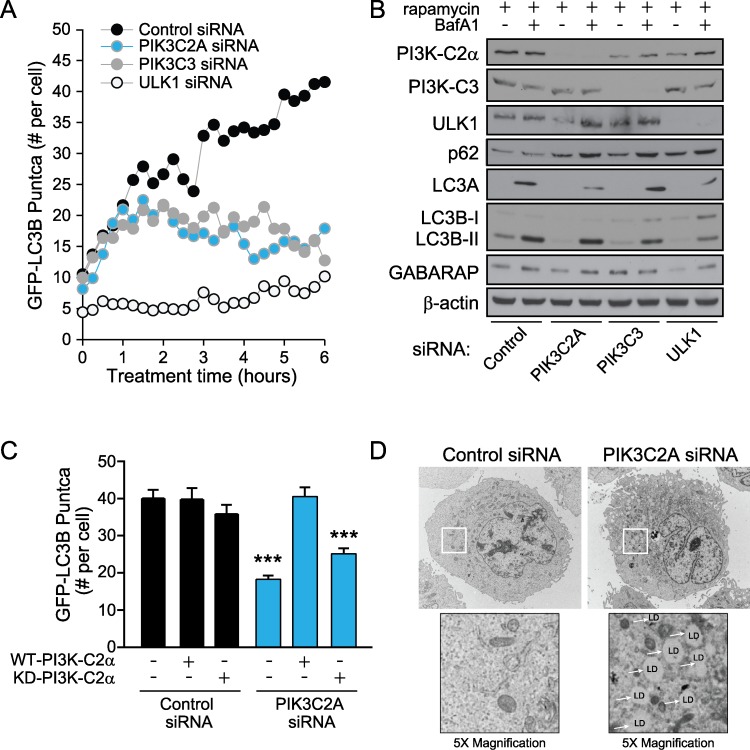
PI3K-C2α knockdown inhibits sustained autophagy and results in the formation of lipid droplets.(A) U2OS cells stably expressing ptfLC3B were transfected with siRNAs directed to PIK3C2A, PIK3C3, and ULK1 for 48 hours. Live-cell imaging was carried out for six continuous hours after addition of rapamycin (50 nM) to measure changes in GFP-LC3 puncta accumulation. (B) U2OS cells were transfected with siRNAs directed to PIK3C2A, PIK3C3, and ULK1 for 48 hours, and then treated with rapamycin (6 hours) to induce autophagy in the absence or presence of BafA1 (90 mins). ATG8 isoforms (LC3A, LC3B, and GABARAP) and p62 (SQSTM1) were examined to detect changes in autophagy. (C) U2OS cells stably expressing EGFP-LC3B were transfected with siRNAs directed to PIK3C2A for 48 hours. After 24 hours, siRNA-resistant wild-type protein (WT-PI3K-C2α) or siRNA-resistant kinase-dead protein (KD-PI3K-C2α) was transfected. After an additional 24 hours, cells were treated with rapamycin for 6 hours and number of puncta per cell counted from exogenous PI3K-C2α expressing cells. Representative images are shown in S3 Fig. Data represent means of n ≥ 25 cells with standard error of the mean. Unpaired t test, comparing experimental to control. ***denotes p < 0.001. (D) Loss of PI3K-C2α increases lipid droplets (LD) as measured by transmission electron microscopy. Insets are 5× magnifications.